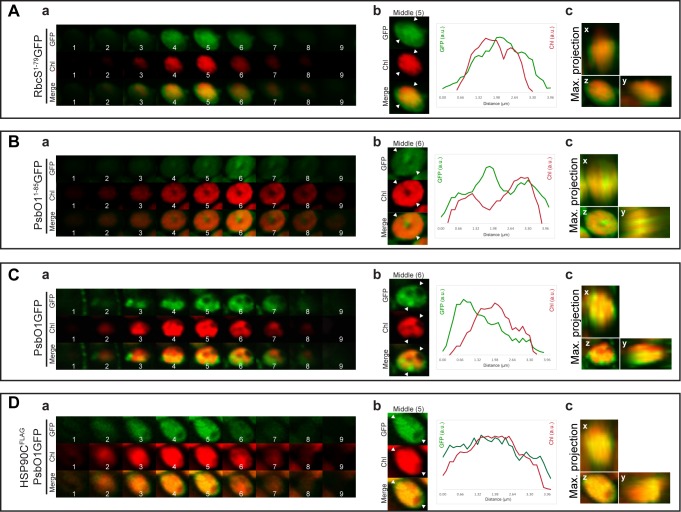
Exogenous HSP90C expression affects PsbO1GFP fluorescence distribution within chloroplasts.Confocal fluorescence images of mesophyll chloroplasts expressing RbcS1-79GFP (A), PsbO11-85GFP (B), PsbO1GFP without (C) or with co-expression of HSP90CFLAG (D). Samples are from 4-DAG cotyledons. (a), fluorescence images for GFP, chlorophyll and the merged shown as continuous z-stacks. (b), fluorescence intensity profiles for GFP and chlorophyll analyzed using representative middle slices. (c), the maximum intensity projection of the x-axis, y-axis and z-axis.